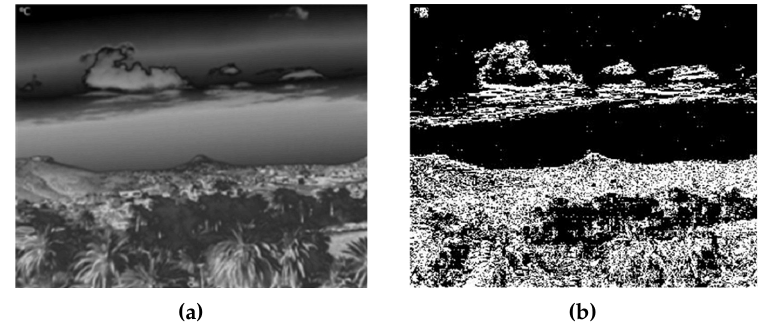
Figure 6. Binarized temperature difference image generation based on the thermographic image. ( a ) Thermographic image converted to 256-level grayscale. ( b ) Binarized temperature difference